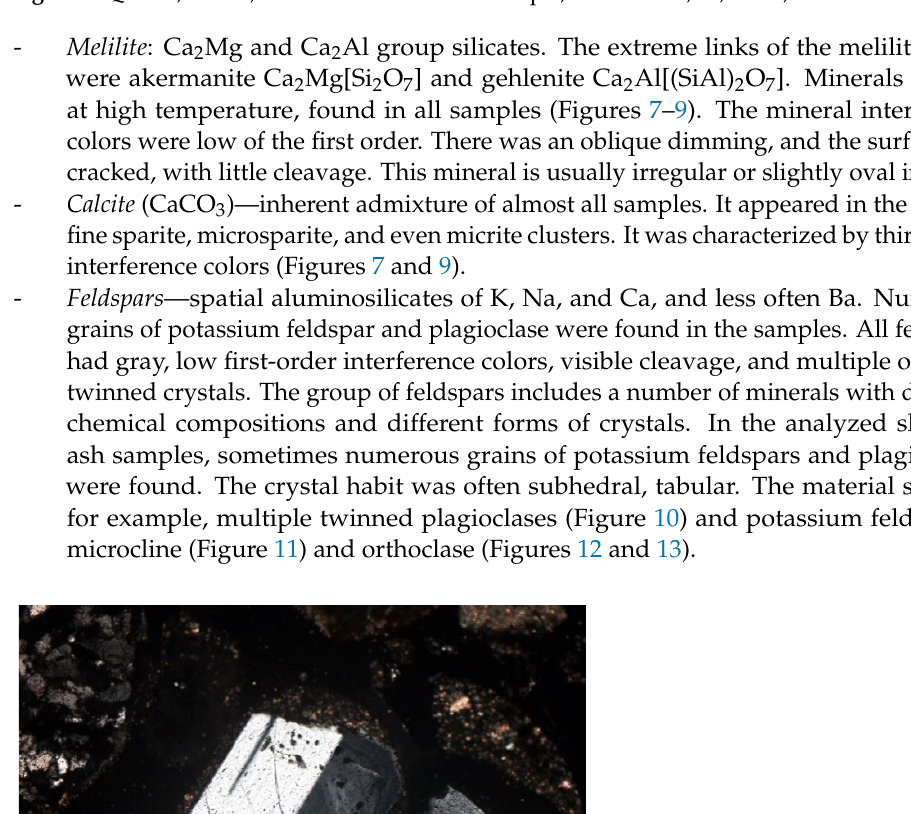
Figure 9. Quartz, calcite, and melilite in the SP2 sample, thin section, 2P, 100×, transmitted light.